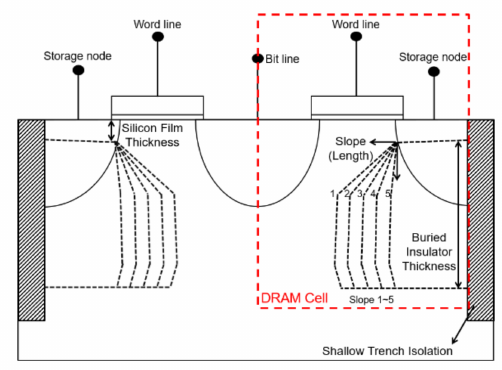
Figure 2. Several types of PiFET structures, according to the silicon film thickness and the slope.